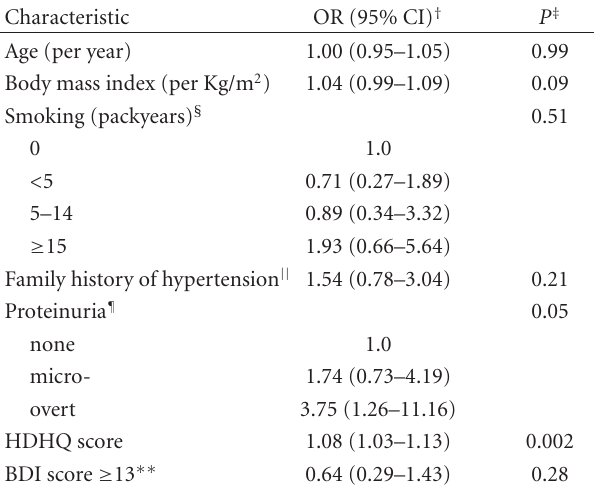
Table 3: Six-year incidence of hypertension ∗ by baseline character- istics: multivariate analysis.